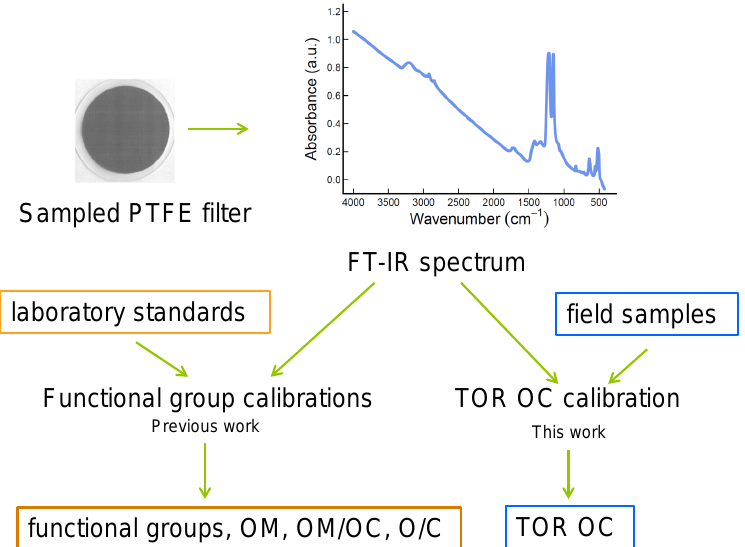
Figure 1. FTIR absorbance spectra from particulate matter collected on PTFE filters can be used for measuring OM; OM / OC; organic functional groups; and, from the work presented here, TOR OC. Previous work on functional group calibrations includes CH groups from saturated (Ruthenburg et al., 2014), unsaturated and ring structures (Gilardoni et al., 2007; Maria et al., 2003; Russell et al., 2009); amine CNH 2 (Liu et al., 2009; Maria et al., 2003); alcohol (Ruthenburg et al., 2014) and phenol COH (Bahadur et al., 2010; Russell et al., 2010; Takahama et al., 2013); organosulfate COSO 3 by solvent rinsing (Hawkins et al., 2010; Maria et al., 2003); organonitrate CONO 2 groups (Day et al., 2010); carboxylic COH (Liu et al., 2009; Ruthenburg et al., 2014; Takahama et al., 2013); and carbonyl CO (Gilardoni et al., 2007; Maria et al., 2003; Ruthenburg et al., 2014; Takahama et al.,